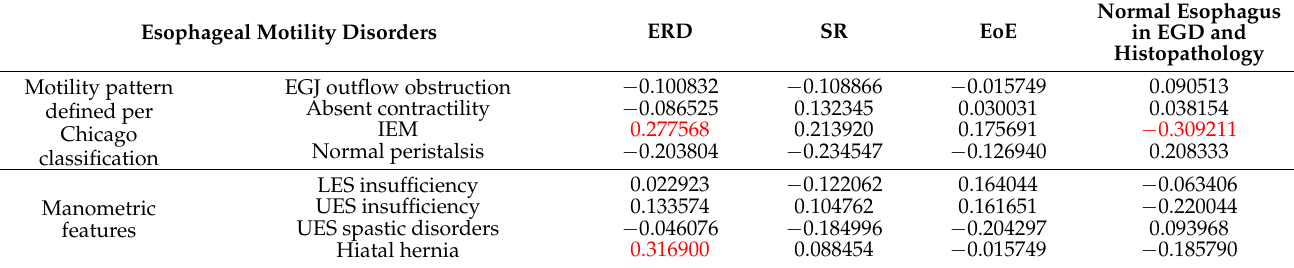
Table 2. Spearman’s rank correlation coefficients between diseases diagnosed based on endoscopic and histopathological examination and manometric patterns and features. Statistically significant—in red.